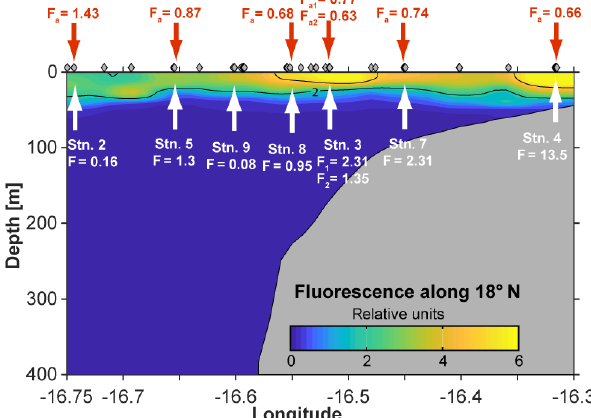
Figure 5. Atmospheric dFe fluxes ( F a ; red) and vertical dFe fluxes ( F ; white) in micromoles per square meter per day (µmolm − 2 d − 1 ) along the transect at 18 ◦ 20 (cid:48) N in June